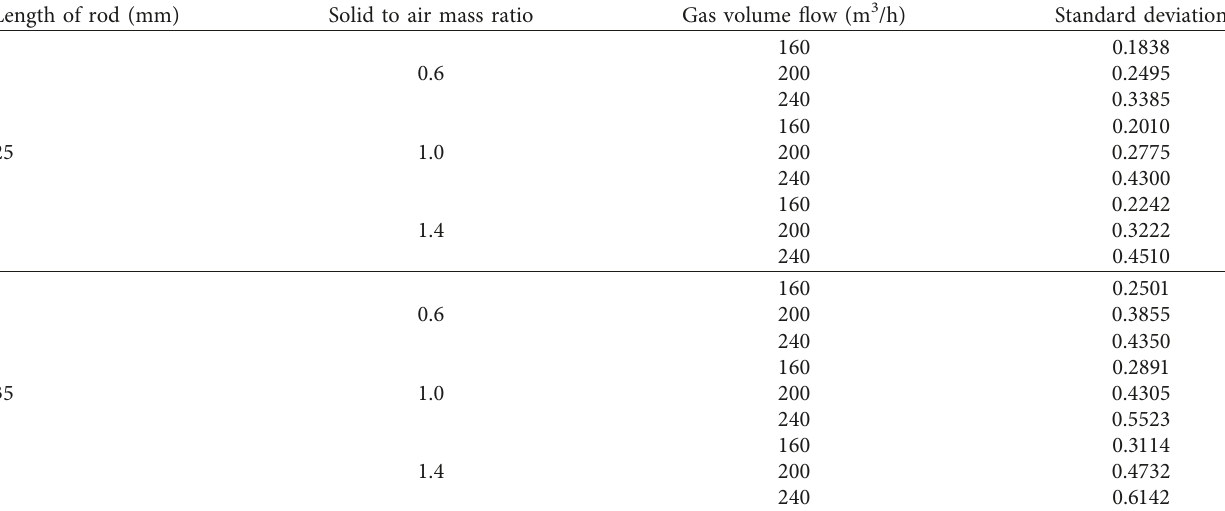
Figure 7: (a) Standard deviation of rod length 25mm for different gas volume flows and different solid to air mass ratios; (b) standard deviation of rod length 35mm for different gas volume flows and different solid to air mass ratios. Table 1: Standard deviation of different